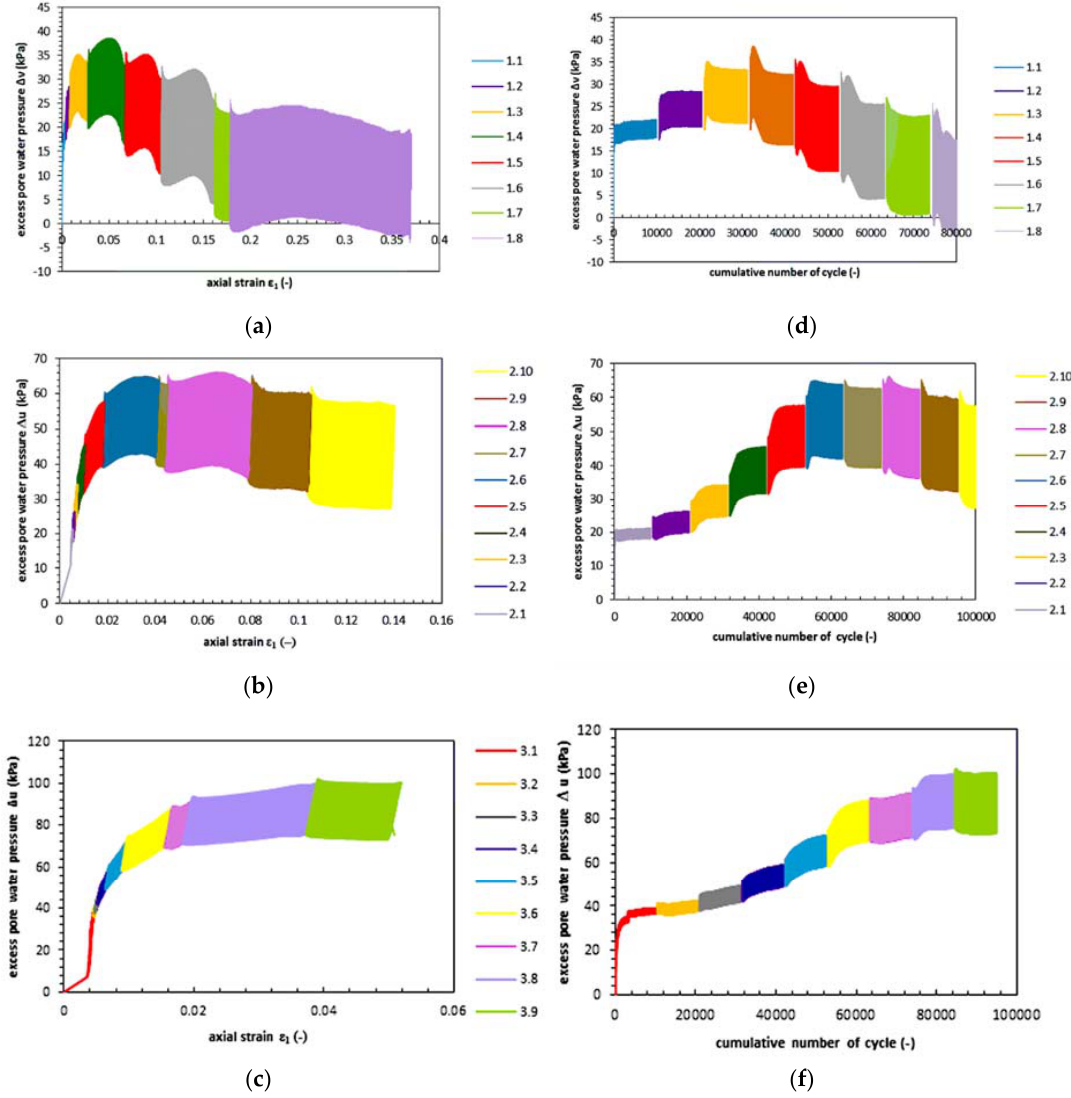
Figure 5. Excess pore pressure generation during the three tests for radial stress versus axial strain ε 1 for σ ’ 3 ( a ) 45 kPa, ( b ) 90 kPa, ( c ) 135 kPa and versus the number of cycles for σ ’ 3 ( d ) 45 kPa, ( e ) 90 kPa, and ( f ) 135 kPa.